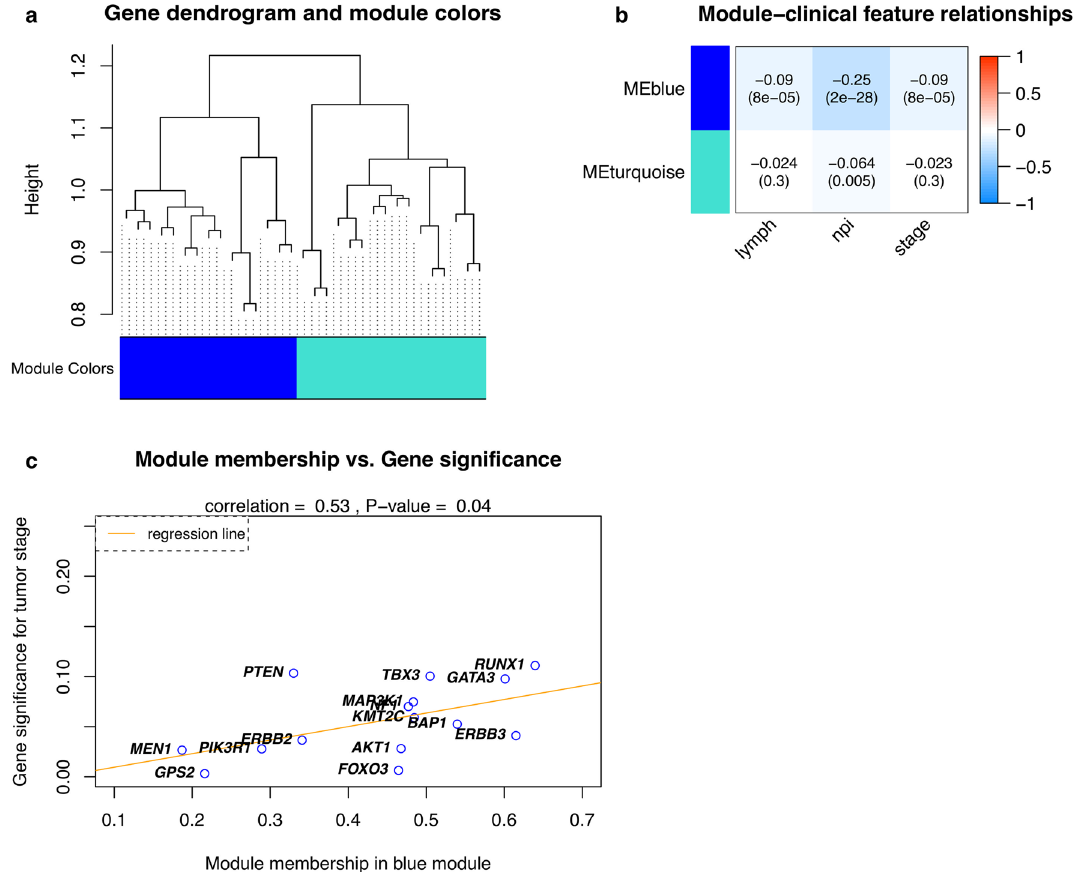
Figure 3. Co-expression network analysis for module-clinical feature associations. ( a ) Dendrogram of the identified driver genes on Topology Overlap Matrix-based dissimilarity . The dendrogram height corresponds to the coefficient of dissimilarity matrix that is for every pair of 31 driver genes, in which the low dissimilarities indicate two driver genes are close, whereas the high dissimilarities imply two driver genes are distant apart. Two co-expressed modules were detected and are shown in different colors. ( b ) Module–feature associations. Each row corresponds to a module eigengene (ME), column to a feature. Each cell contains the corresponding correlation coefficient and P -value. ( c ) A correlation between gene significance for tumor stage and module membership in the blue module. There is a significantly strong positive correlation between Gene significance and Module membership in this module ( r = 0.58, P -value = 0.04). Significant genes (i.e., high Gene significance and high Module membership) in a single module are the ones having a significant association with a clinical feature considered. Abbreviation: lymph: number of positive lymph nodes, and npi: the Nottingham prognostic index,